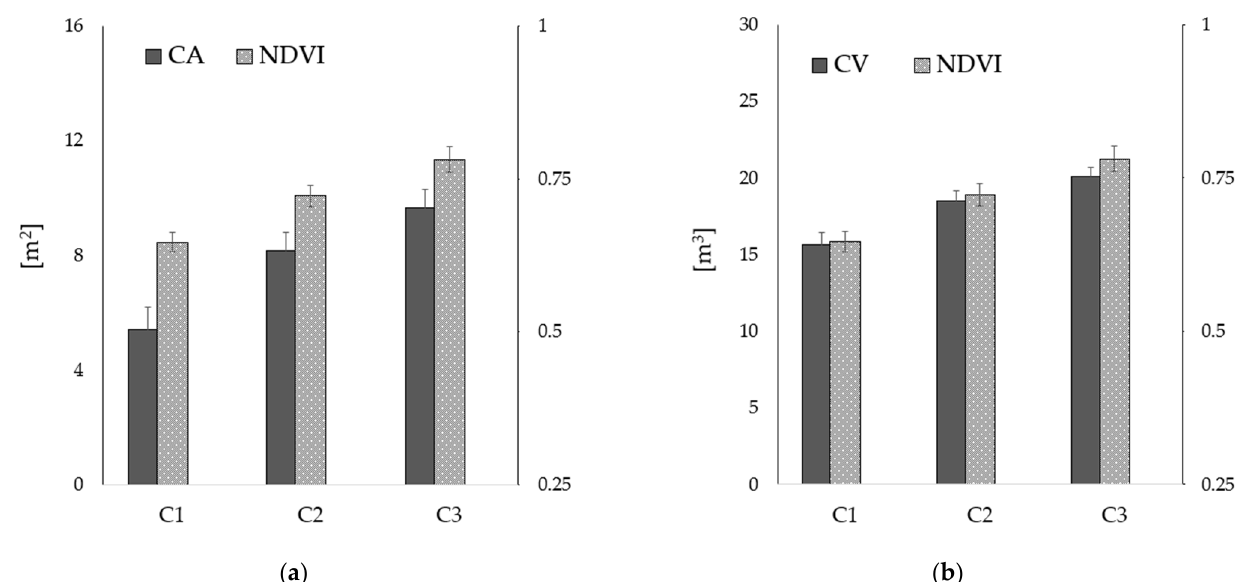
Figure 9. ( a ) CA and NDVI values ( ± st. dev) for the three clusters; ( b ) CV and NDVI values ( ± st. dev) for the three clusters.